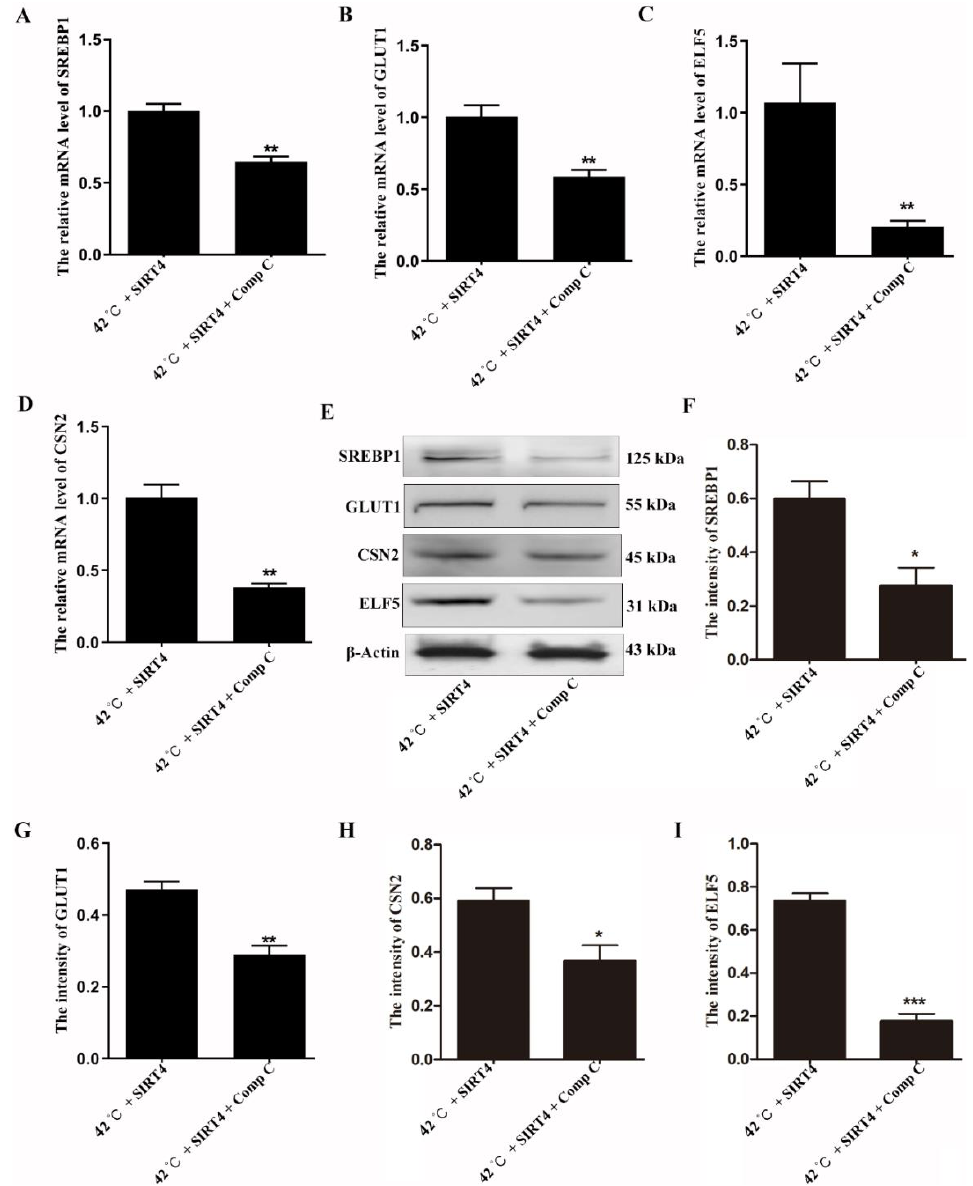
Figure 6. Inhibition of AMPK blocks the positive function of SIRT4 in milk synthesis in BMECs. ( A – D ) Compound C treatment inhibited the mRNA expression levels of SREBP1, GLUT1, CSN2 , and ELF5 in SIRT4-expressed BMECs under heat stress conditions. ( E – I ) Western blotting results showed that the protein levels of SREBP1, GLUT1, CSN2, and ELF5 were reduced after inhibition of AMPK in SIRT4-expressed BMECs. NC: negative control; Mock: expression of control vector. These results are presented as the mean ± SEM from three independent experiments. * p < 0.05, ** p < 0.01, *** p <